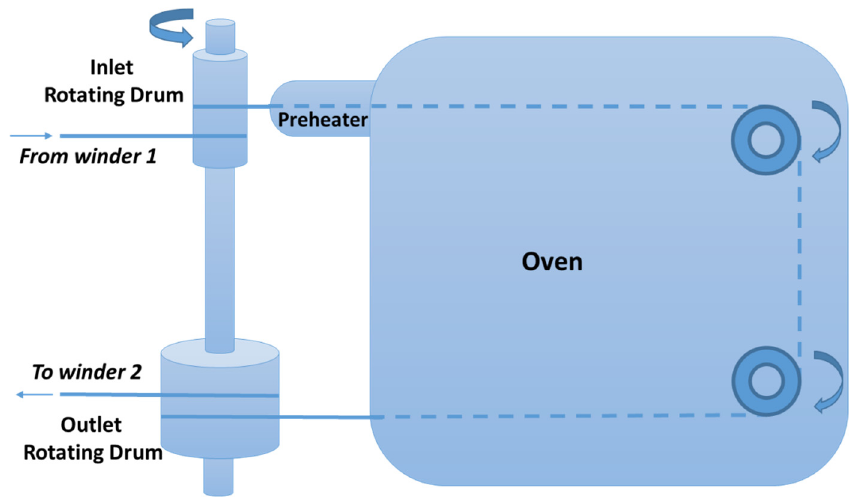
Figure 1. Scheme of the experimental drawing apparatus. In this study, the drawing temperature (inside the oven) was 140 ± 1 ◦ C, while the temperature of the preheater was 120 ± 2 ◦ C. Such temperatures are below the melting point of all the investigated composites, which, as reported in the next sections, ranged between 162 and 166 ◦ C. Moreover, the diameter of the inlet and outlet drum was 20 and 140 mm, respectively. Consequently, the theoretical drawing ratio is equal to